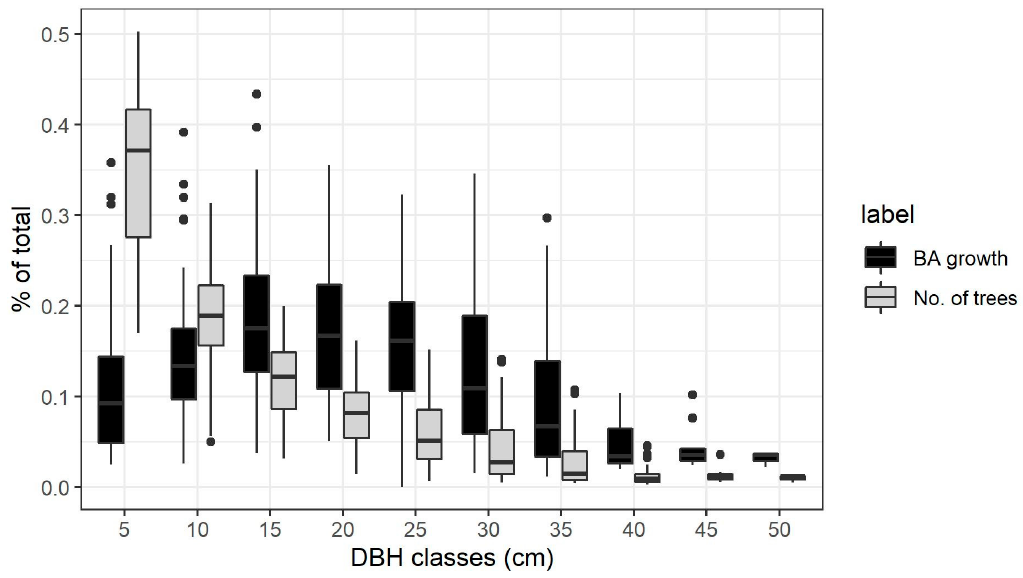
Figure 2. Contribution to total growth and total number of trees for each diameter class, calculated in every plot and measurement period and shown as boxplots.